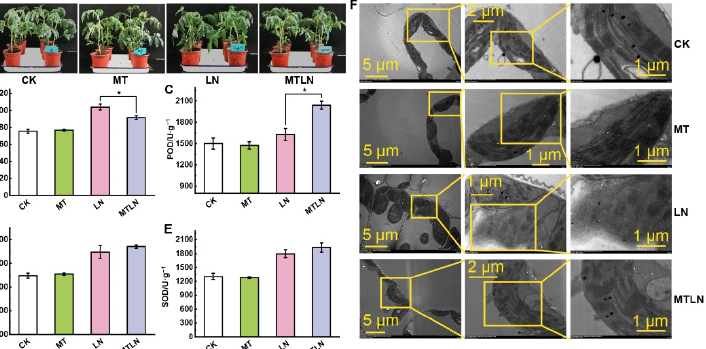
Figure 1. The effect of exogenous melatonin on the growth and antioxidant system of tomato plants subjected to low night temperature. Plant phenotype ( A ); malondialdehyde (MDA) content ( B ); peroxidase (POD) activity ( C ); catalase (CAT) activity ( D ); superoxide dismutase (SOD) activity ( E ); chloroplasts’ ultramicrostructures ( F ). Data are presented as the mean ± standard deviation of four independent biological replicates. * p -value < 0.05; student’s t -test.